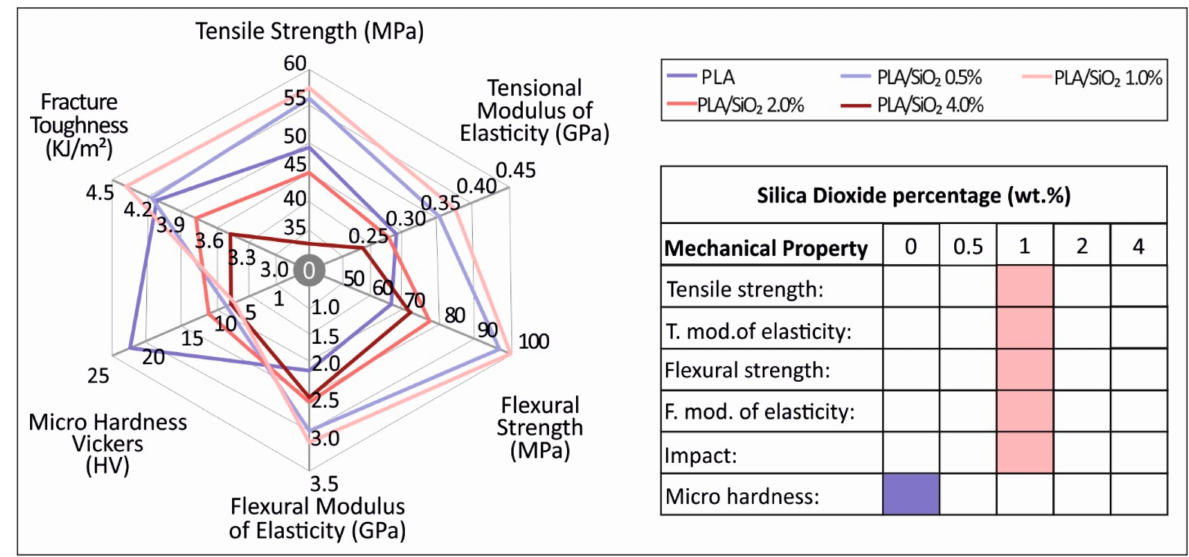
Figure 12. Summary of the mechanical properties results for all materials tested in this study. Highest values measured at each test is marked to the filler percentage